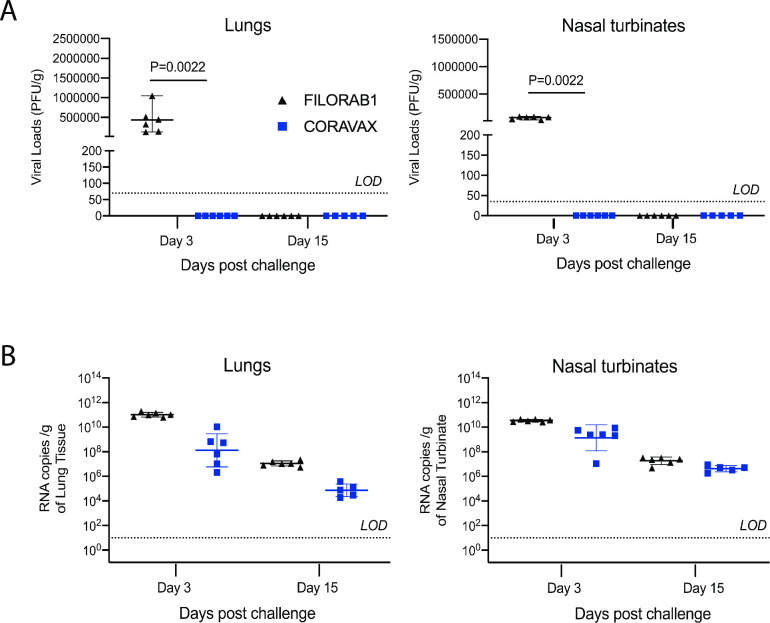
SARS-CoV-2 tissue viral load in hamsters.Hamsters were challenged intranasally with 105 PFU SARS-CoV-2, and half of the animals in each group were euthanized at days 3 and 15 p.c. Right lungs (A, C) and nasal turbinates (B, D) from each animal were homogenized in media and viral loads were determined by plaque assays on Vero E6 cells (A, B) or by qRT-PCR (C, D). The limit of detection for the plaque assay was 70 PFU per lung and 35 PFU per nasal turbinate. The limit of detection for the qRT-PCR assay is 10 copies. The CORAVAX vaccine group is shown in blue and the FILORAB1 group in black. Data represent mean ± S.D., N = 6 for FILORAB1 group day 3 and day 15 time points, and N = 6 for CORAVAX group day 3 and N = 5 for CORAVAX group day 15 time points. P values determined by Mann-Whitney test. Only significant differences are depicted.